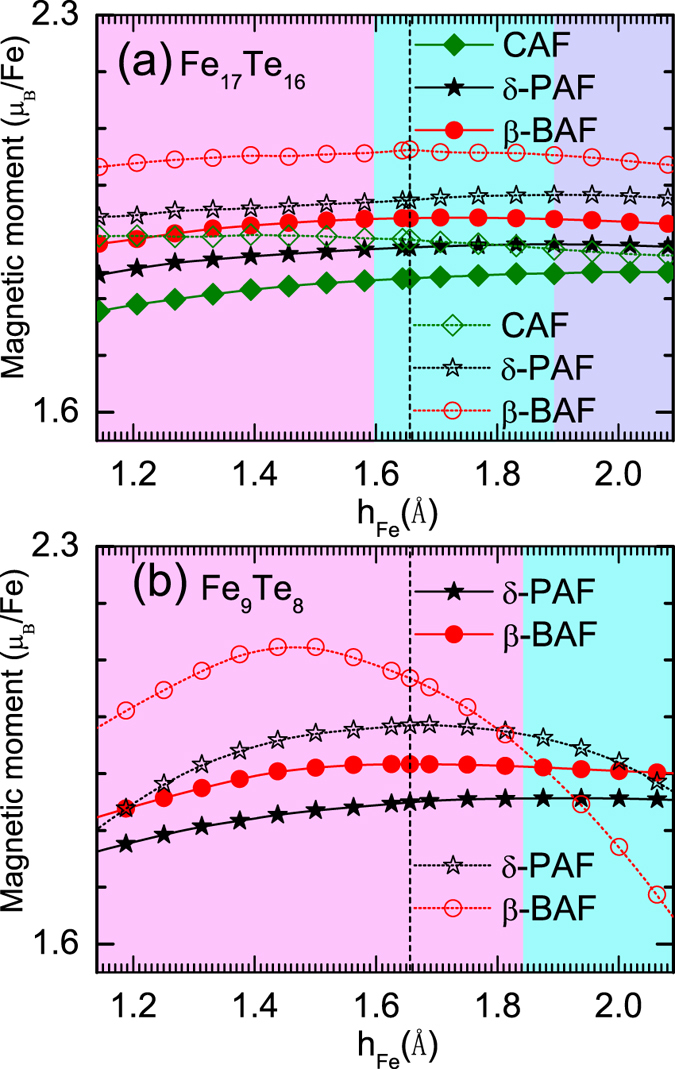
Magnetic moments of the competing magnetic states in the case of Fe17Te16 (a) and Fe9Te8 (b) which corresponds to a stoichiometry of Fe1.0625Te and Fe1.125Te, respectively.Solid symbols represent the magnetic moment per iron in the iron plane while empty symbols denotes the magnetic moment on the interstitial iron. The dashed line indicates the experimental value of the position of interstitial Fe15. Different phases are marked by different colors as indicated in Fig. 3.